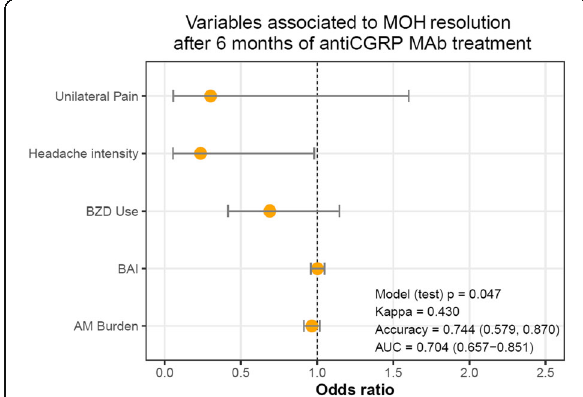
Fig. 2 Odds Ratio (95% CI) estimated from the logistic regression analysis of the significant clinical predictors associated to MO resolution after 6 months of anti-CGRP MAbs treatment. Odds ratio (95% CI) estimated from the 10-fold CV of the stepwise logistic regression with selection criteria of minimizing the AIC for a variable to be eliminated from the selected model. The final